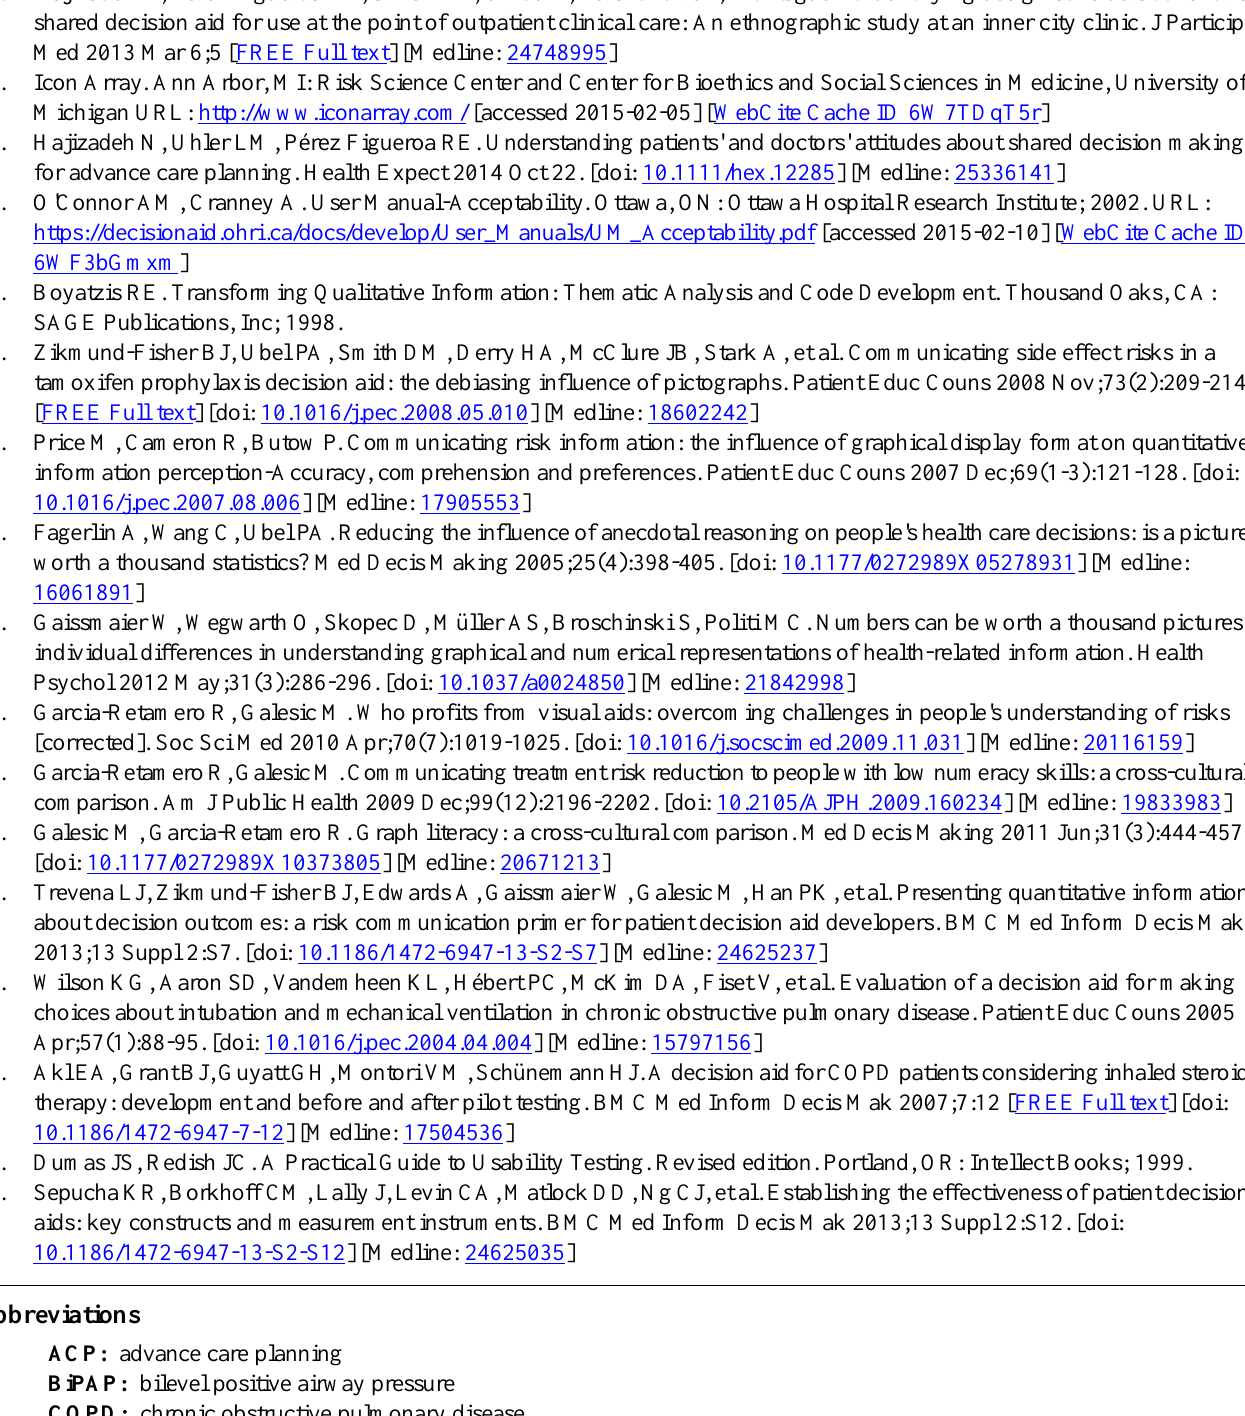
ACP: advance care planning BiPAP: bilevel positive airway